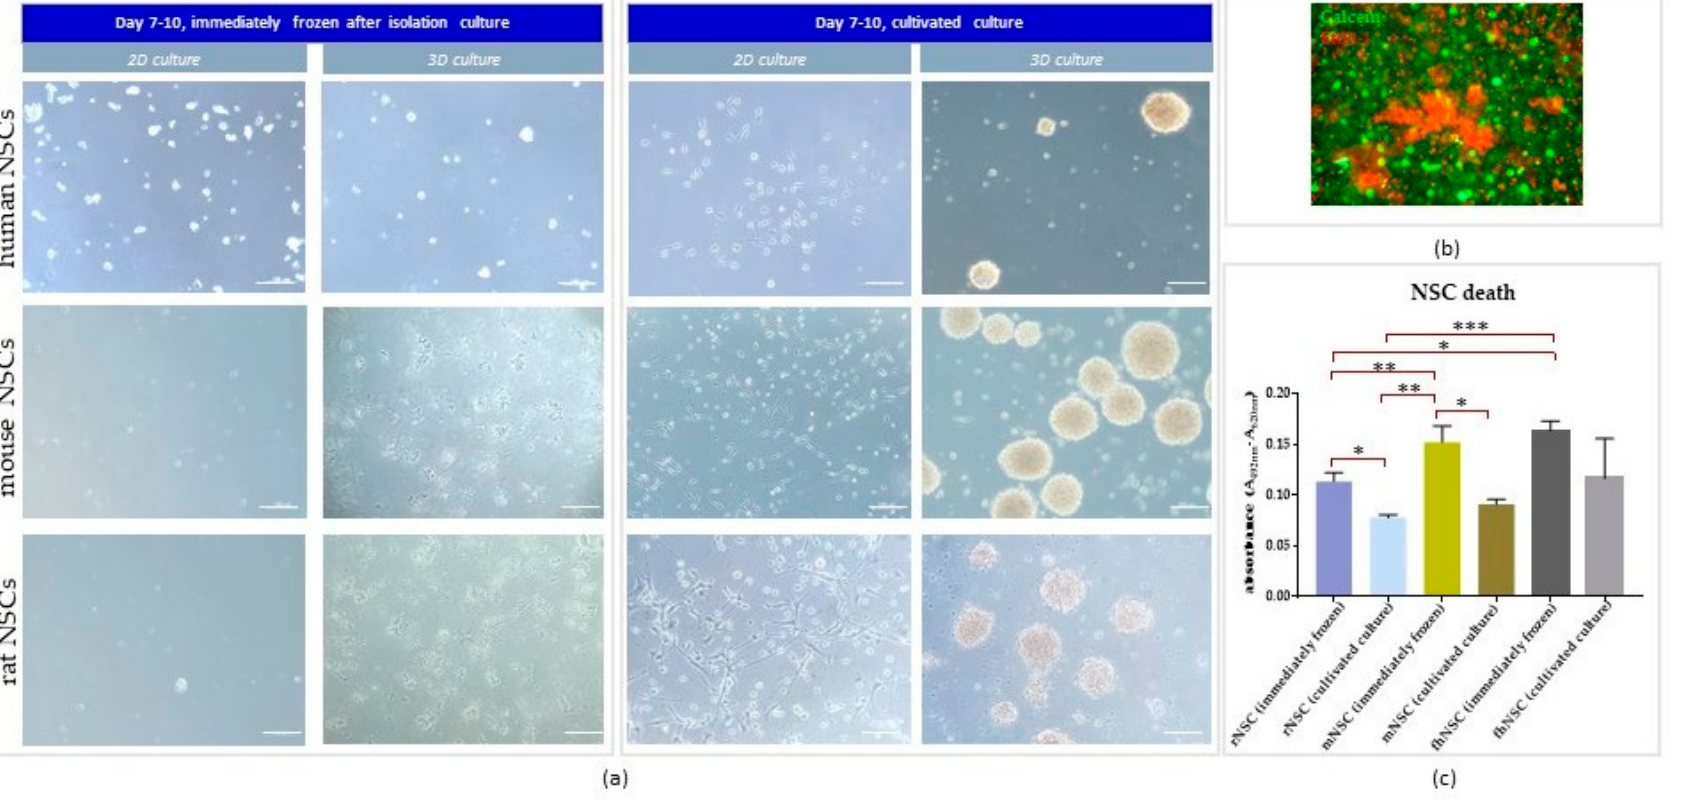
Figure 4. The effect of freshly isolated NSCs’ cryopreservation on their viability and growth potential. ( a ) NSCs on days 7–10 of 2D and 3D culture after the isolation: NSCs frozen right after isolation (on the left) and NSCs after the standard cultivation procedure (on the right). ( b ) Immunofluorescent analysis of dead (stained with red Edth-1) and live (stained with green calcein) immediately frozen hNSCs. ( c ) Immediately frozen and cultivated NSCs’ death depending on the species after 24 h of 3D culture. Cell culture conditions: 5% O 2 , 5% CO 2 , 37 ◦ C. N = 3. The results of all experiments presented above are expressed as mean values of three experiments ± SEM. The differences were considered statistically significant when the p -value < 0.05. Statistical significance level: * for 0.01 < p < 0.05, ** for 0.001 < p < 0.01, and *** for 0.0001 < p < 0.001.